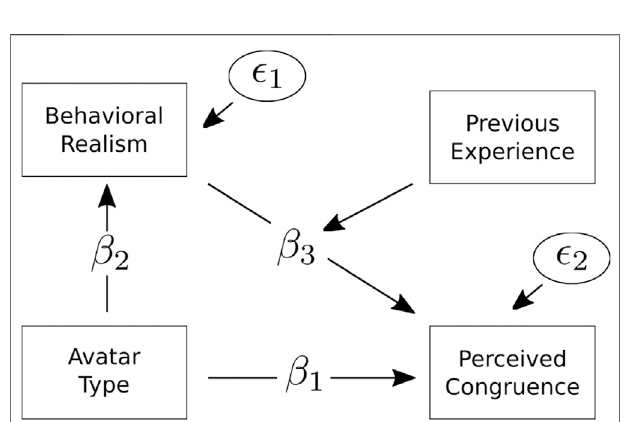
FIGURE 8 | The LMM with moderated mediation and stimulus as level two units. It was estimated to study whether differences in avatar type with respect to perceived congruence are driven by differences in behavioral realism and whether this effect differs depending on the amount of the user experience with avatars. β , regression weights; ϵ , residual variance.